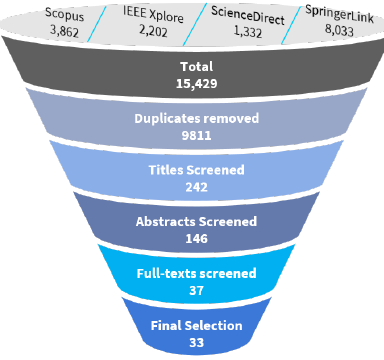
Figure 2. Survey